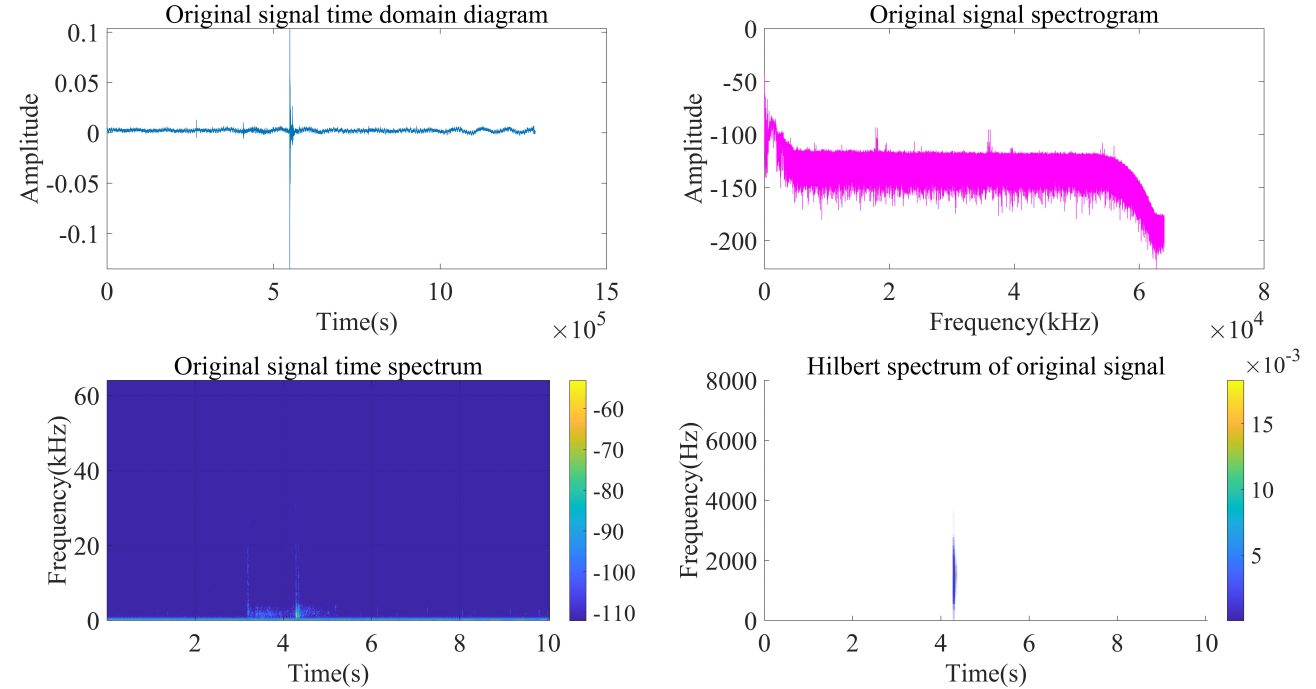
Figure 16. Third-channel acquisition signal processing and